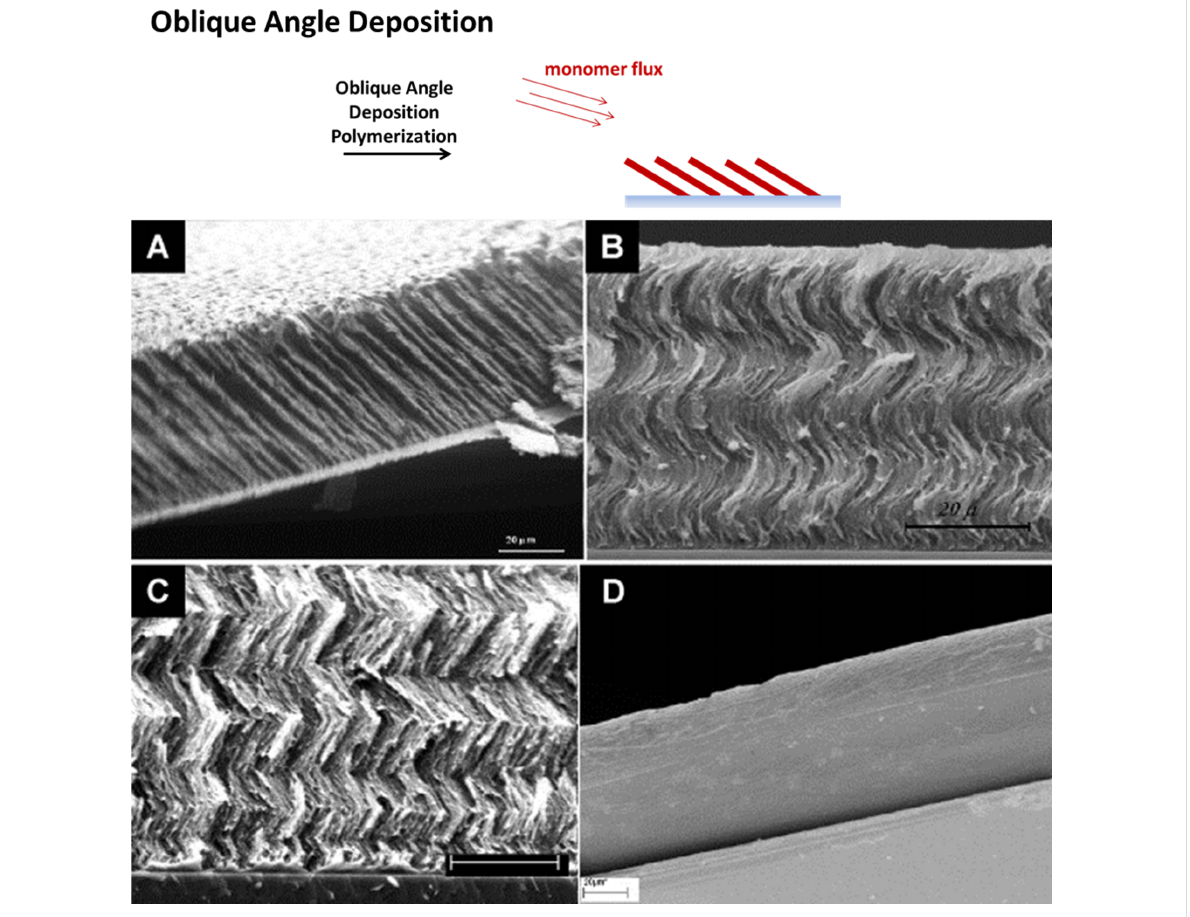
Figure 5: Polymer structures via oblique angle polymerization: by manipulating the substrate rotation during the deposition, complex architectures such as A) columnar, B) helical or C) chevron patterns can be achieved. In contrast to this, D) displays the corresponding cross-sectional scanning electron micrograph of a planar PPX-n film. All scale bars are 20 μ m. Reprinted with permission from [40], copyright 2008